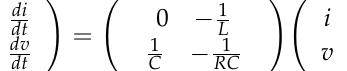
Figure 5. Proposed algorithm flow chart.